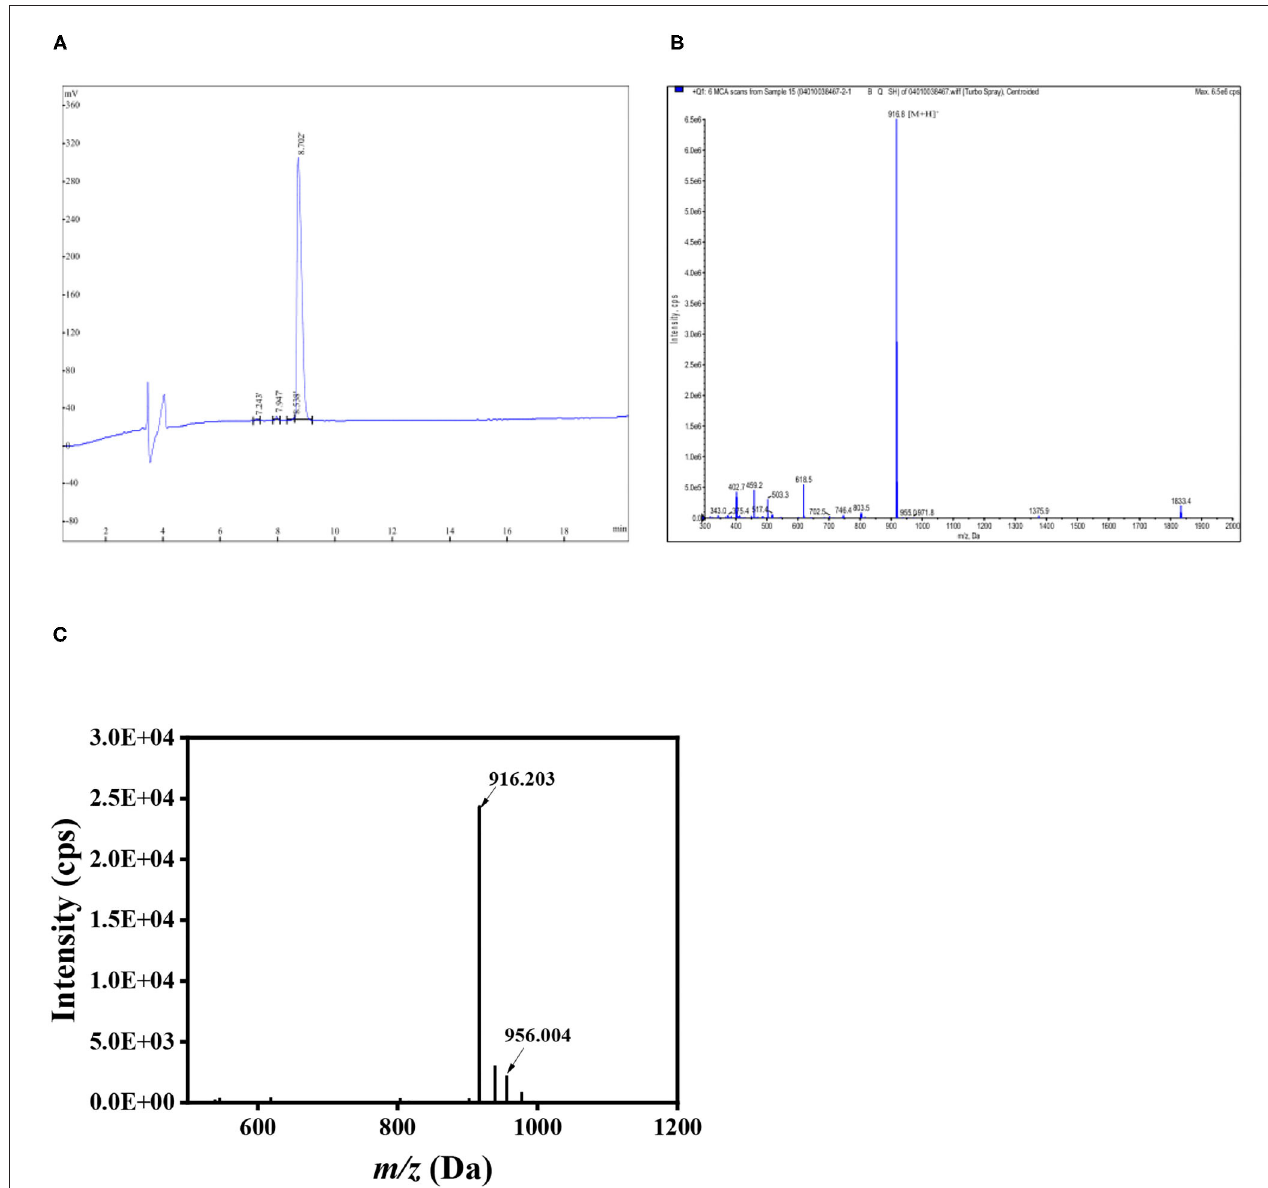
FIGURE 3 | Peptide LGKDQVRT identified by HPLC and Mass spectrum. (A) HPLC of LGKDQVRT. (B) Mass spectrum at the m/z of 916.8 Da for LGKDQVRT. (C) LGKDQVRT-calcium complex identified using MALDI-TOF MS.